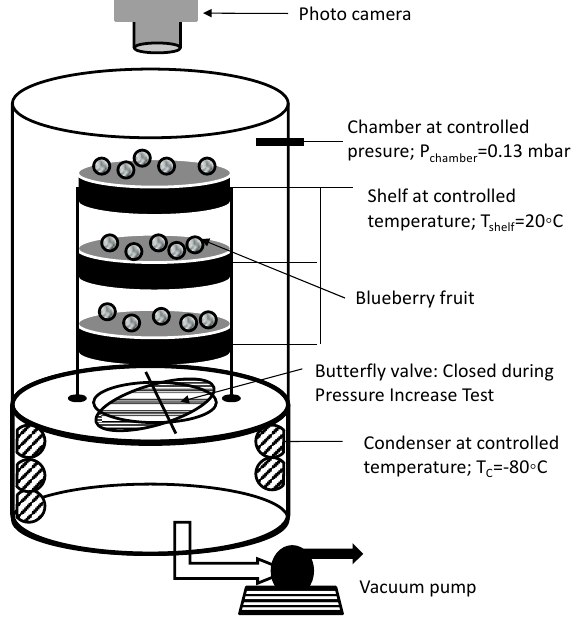
Figure 2. Freeze-drying system arrangement and its processing condition set up.